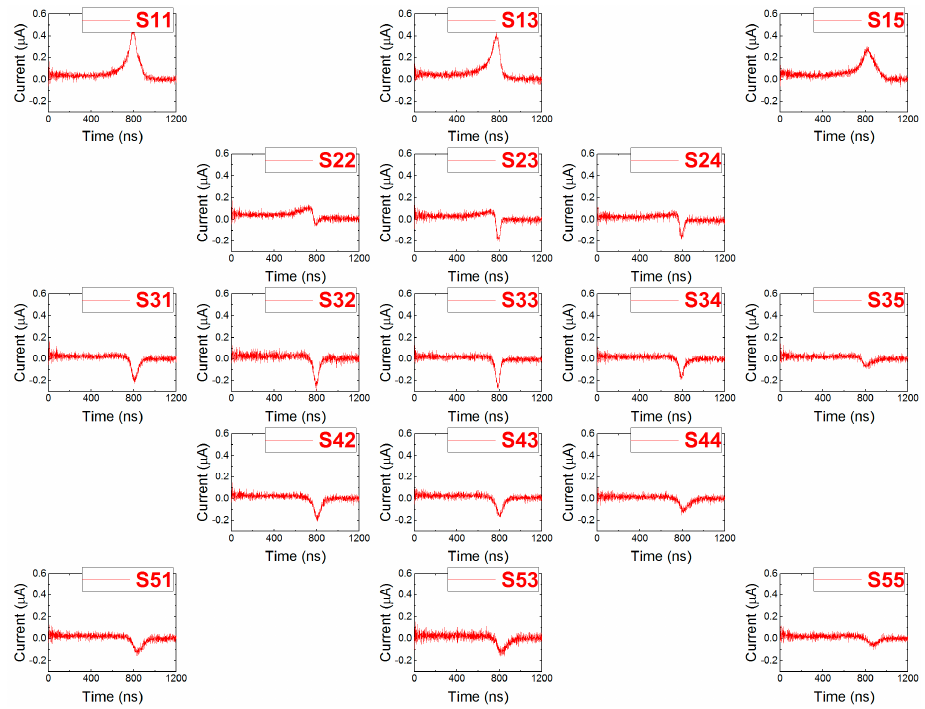
Figure 10. Current waveforms measured on GR at 400 V bias while illuminating different spots.